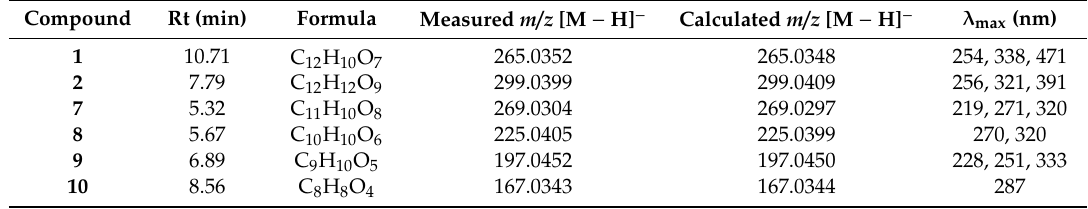
Table 2. HPLC coupled with diode array detection (DAD) and MS parameters of Ech A ( 1 ) and its oxidation products 2 and 7 – 10